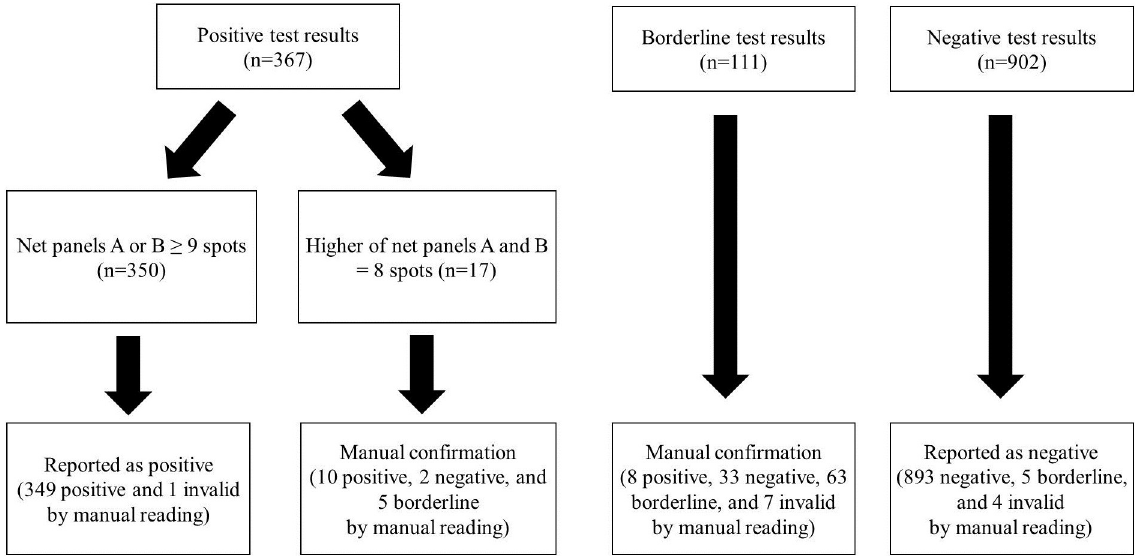
Fig 2. A novel strategy for interpreting the T-SPOT. TB test results by an ELISPOT plate imager on the basis of study findings. The test result is reported as positive if the spot count in net panel A or net panel B is greater than or equal to 9. Manual confirmation is warranted for borderline test results and positive test results with the maximum net spot count of 8. Negative test results are reported as such.